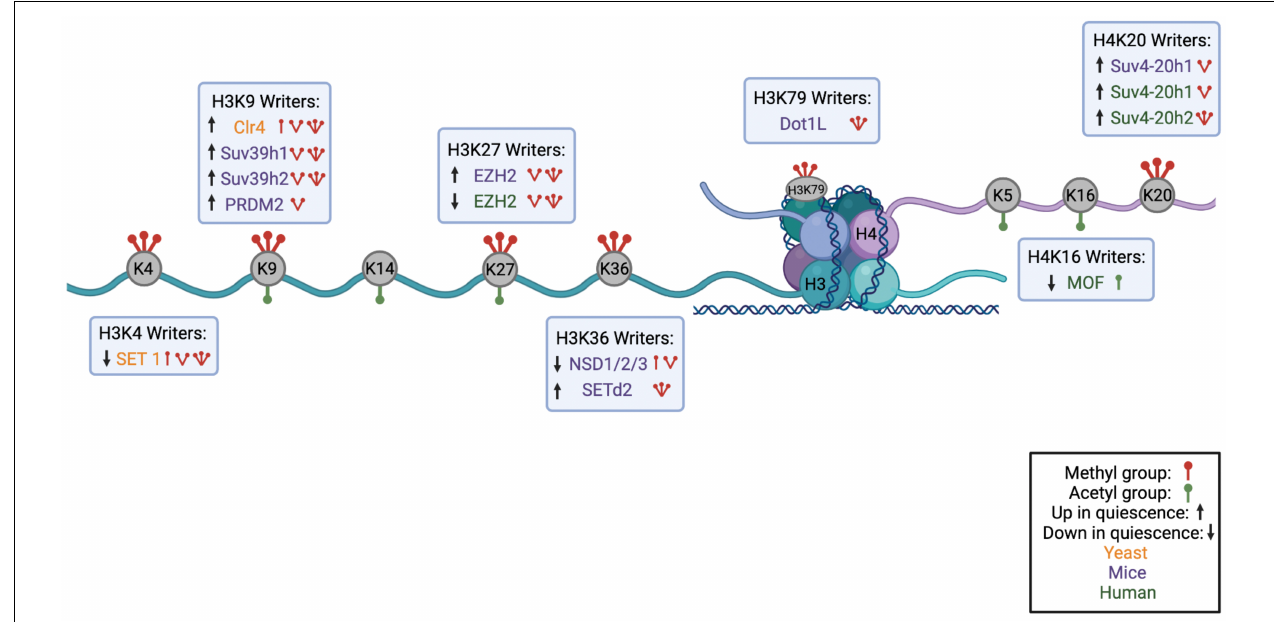
FIGURE 2 | Summary of Histone Modifications on H3 and H4 Tail with their Corresponding Writer Enzymes. A schematic showing the nucleosome structure with H3 and H4 histone cores and corresponding N-terminal tails. Lysines available for methylation or acetylation are in gray with red icons indicating methyl groups and green icons indicating acetyl groups. Under or above each histone mark are the corresponding writer enzymes for each lysine with an indication of the number of methyl groups or acetyl groups each writer deposits. Writers found in yeast are shown in orange, in mouse models in purple, and in humans in green. Up or down arrows indicate whether the writer is upregulated or downregulated in quiescence (Figure made in